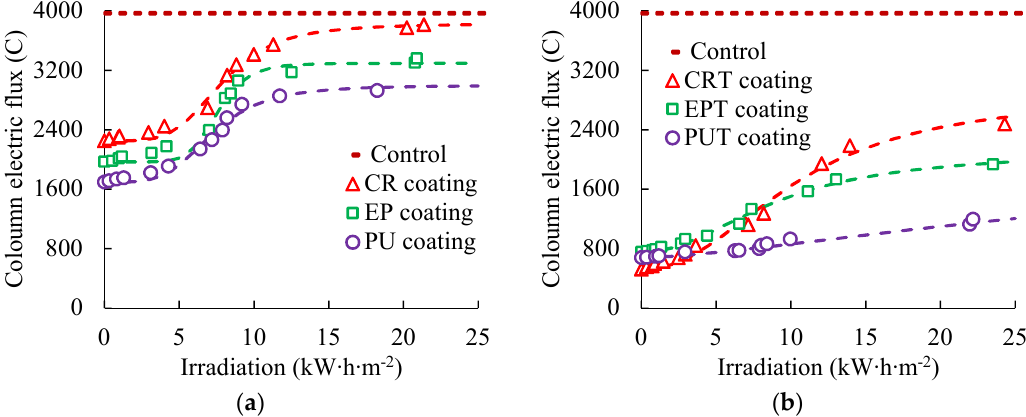
Figure 3. Development of Coulomb electric fluxes of coated concrete with ultraviolet irradiation. ( a ) Ordinary coatings; ( b ) Nano-TiO 2 -modified coatings.